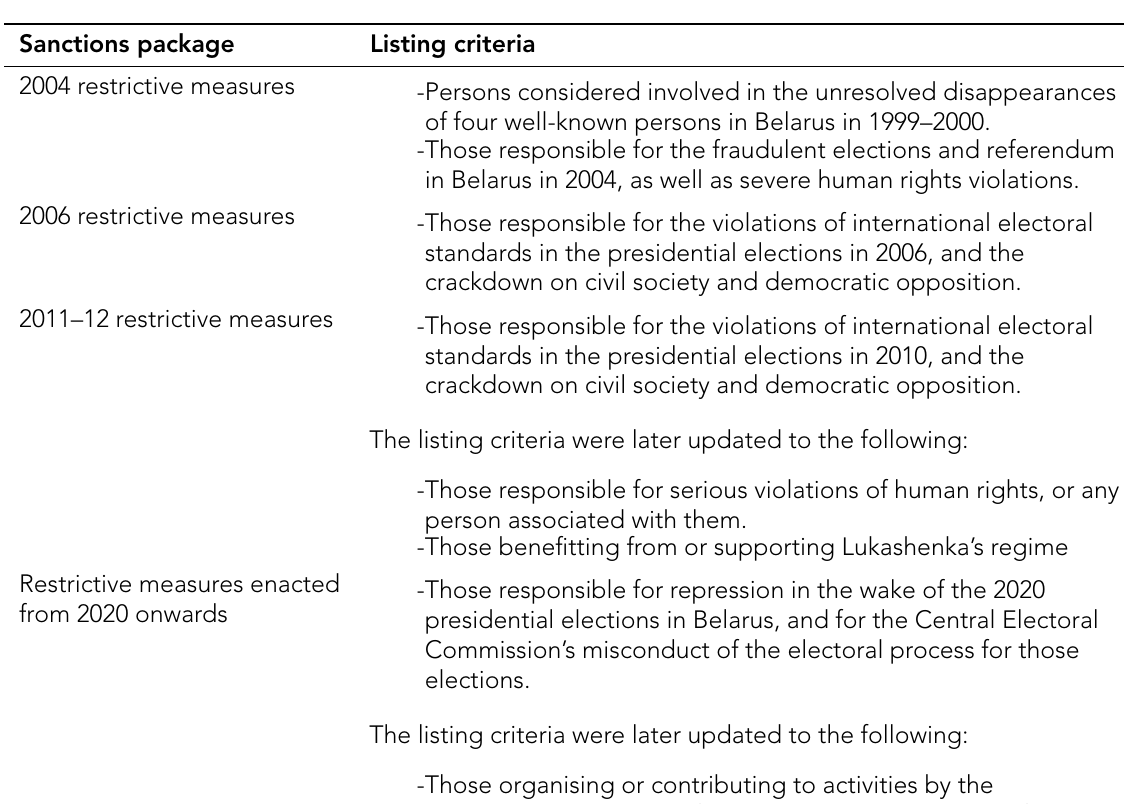
Table 1 summarises the evolution of the listing criteria against Belarus: Table 1. Evolution of the listing criteria against